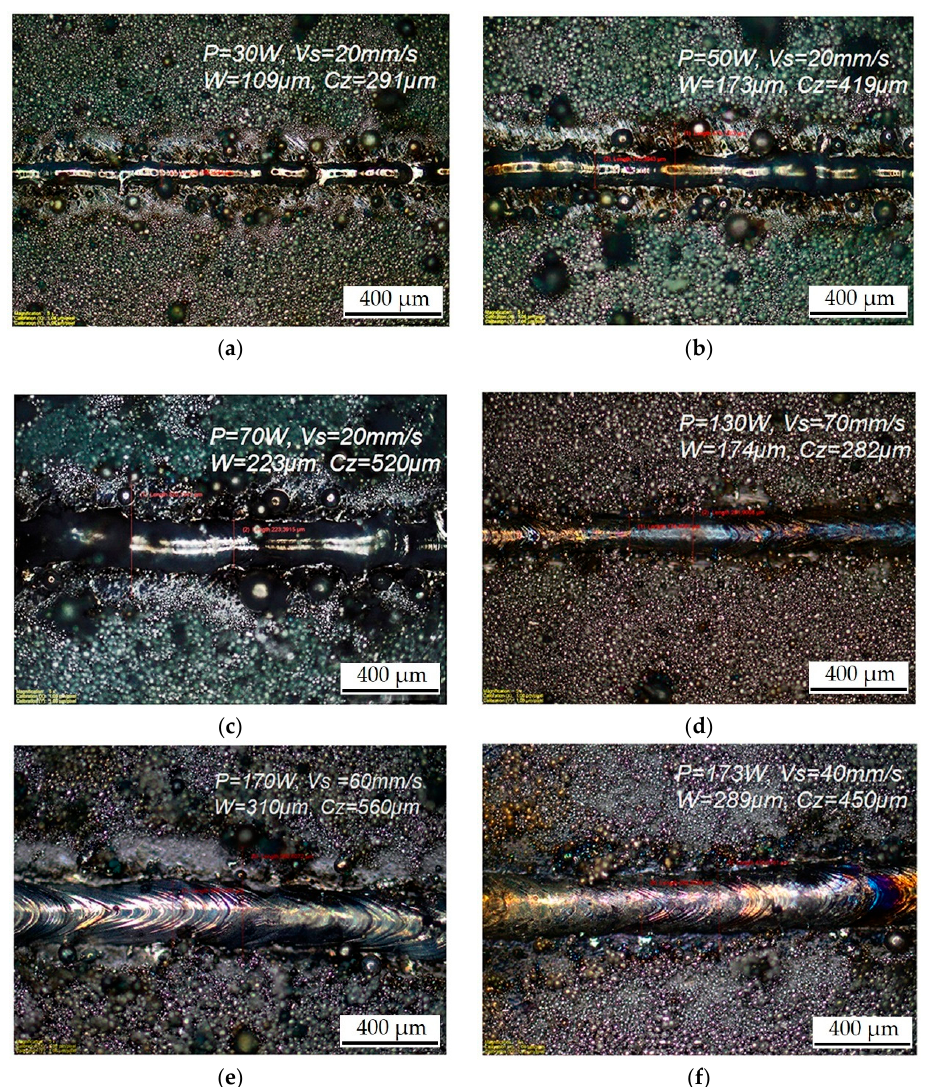
Figure 9. General view of the single tracks: ( a ) Gaussian in the first process gap; ( b ) flat top in the first process gap; ( c ) donut in the first process gap; ( d ) Gaussian in the second process gap; ( e ) flat top in the second process gap; ( f ) donut in the second process gap. W is the track width; C z is the optically measured width of a heat-affected zone.